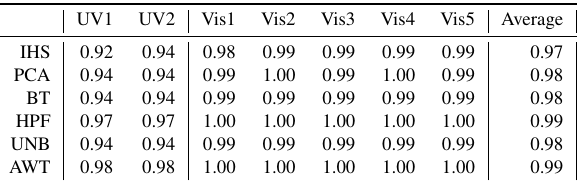
Figure 3: Spectral Angle Mapper (SAM) images for (A) Ina-D and (B) South Ray. Pixel value is the spectral angle between WAC visible bands before and after image fusion. Contrast limit maximum saturates top 2% of Ina-D PCA SAM pixel values. Table 6: South Ray: Correlation Coefficient (MS,DHRMS)